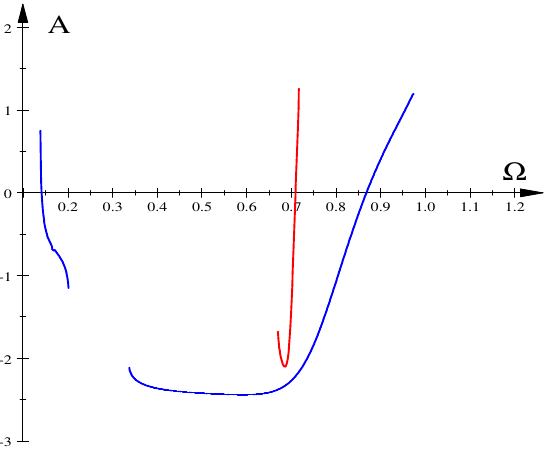
Figure 10. Bifurcation diagrams: µ = 0.75, ν = 1, G = 0.05—red, G = 0.6—blue. The blue bifurcation diagram of Figure 10 shows two stable branches corresponding to two disjoint parts of the blue amplitude profile in Figure 9. In the case of the red bifurcation diagram of Figure 10, we see that only the right red amplitude profile shown in the left Figure 9 is